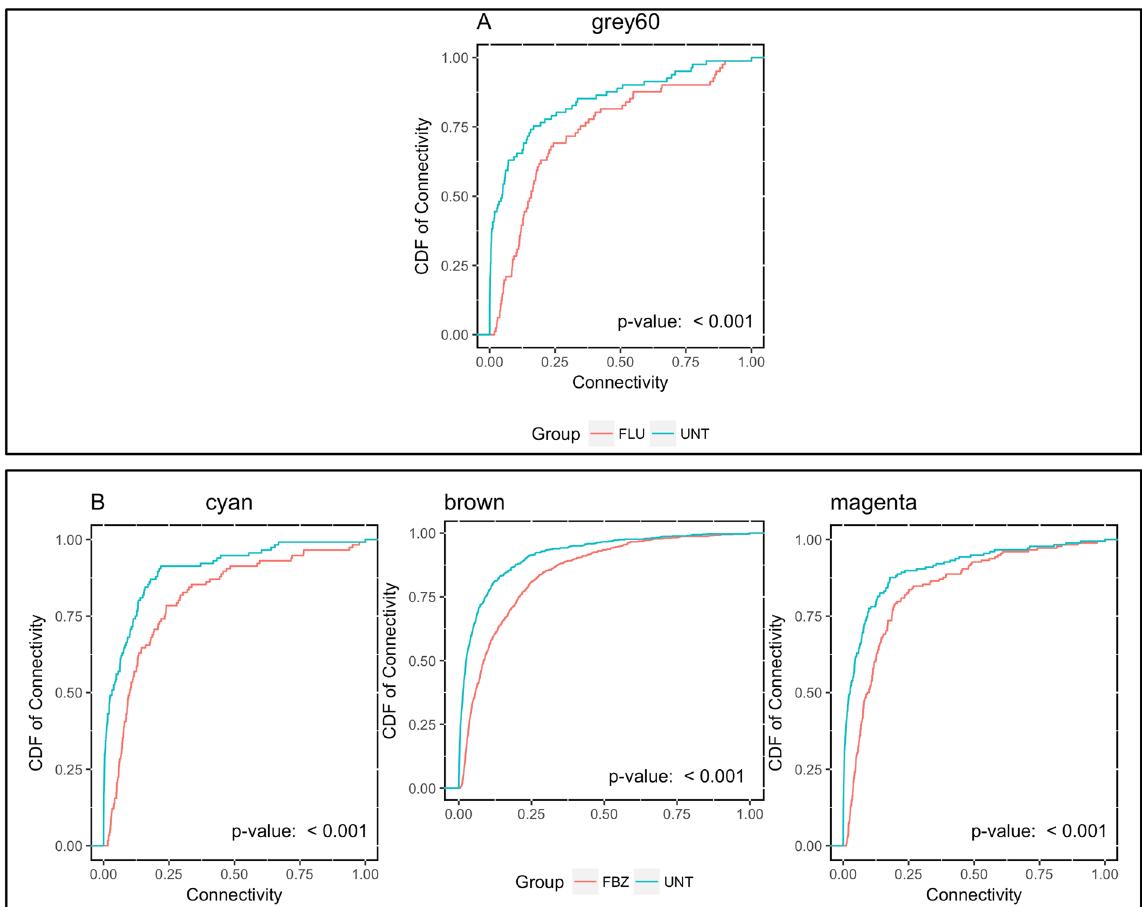
Figure 5. Cumulative density function (CDF) of differential connectivity values between animals administered Flunixin Meglumin (FLU; Panel A) and Fenbendazole (FBZ; Panel B) versus untreated (UNT) animals within modules associated with pharmacokinetic phenotypes and the significance based on the Kolmogrov-Smirnov